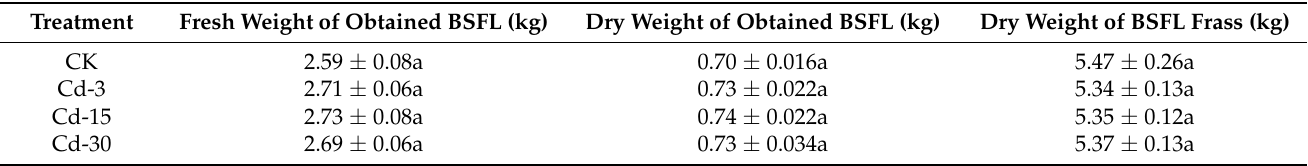
Table 1. Production performance of transforming pig manure by BSFL.